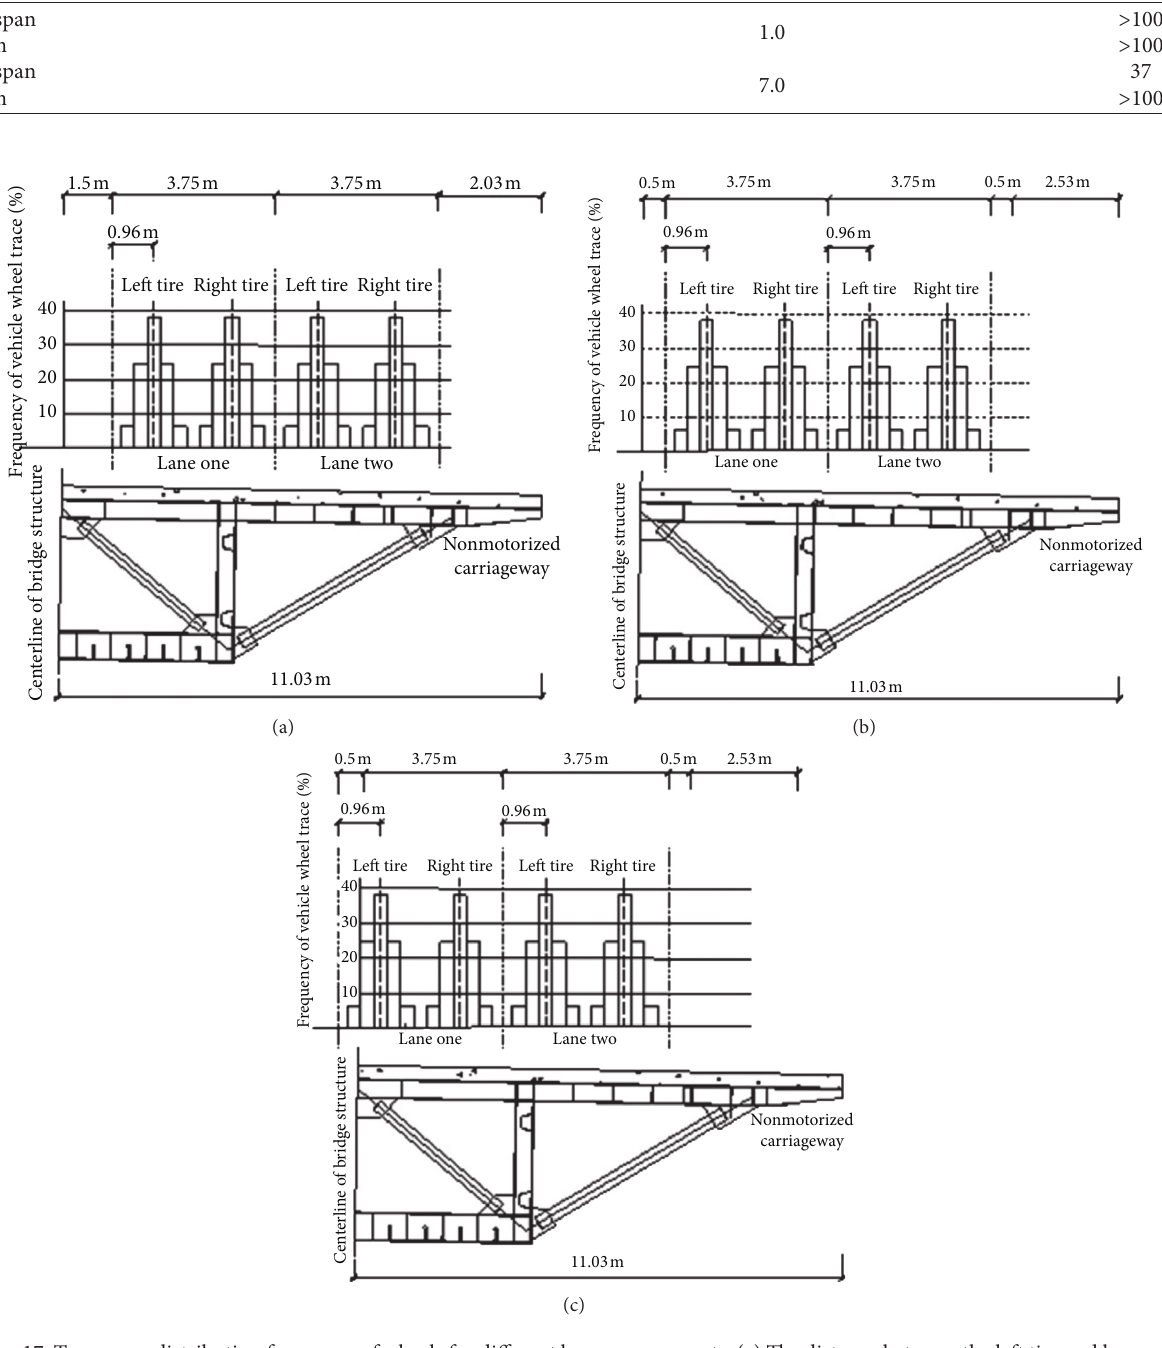
Figure 17: Transverse distribution frequency of wheels for different lane arrangements. (a) The distance between the left tire and lane one is 0.96 m; (b) the distance between the left tire and lane two is 0.96 m; (c) the distances between the left tire and the center line of bridge structure, the left tire and lane two both are 0.96